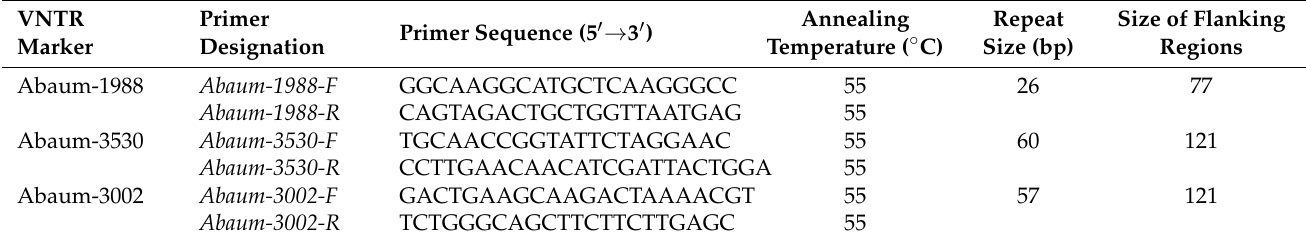
Table 2. Primers, PCR conditions, and characteristics of VNTRs analyzed.